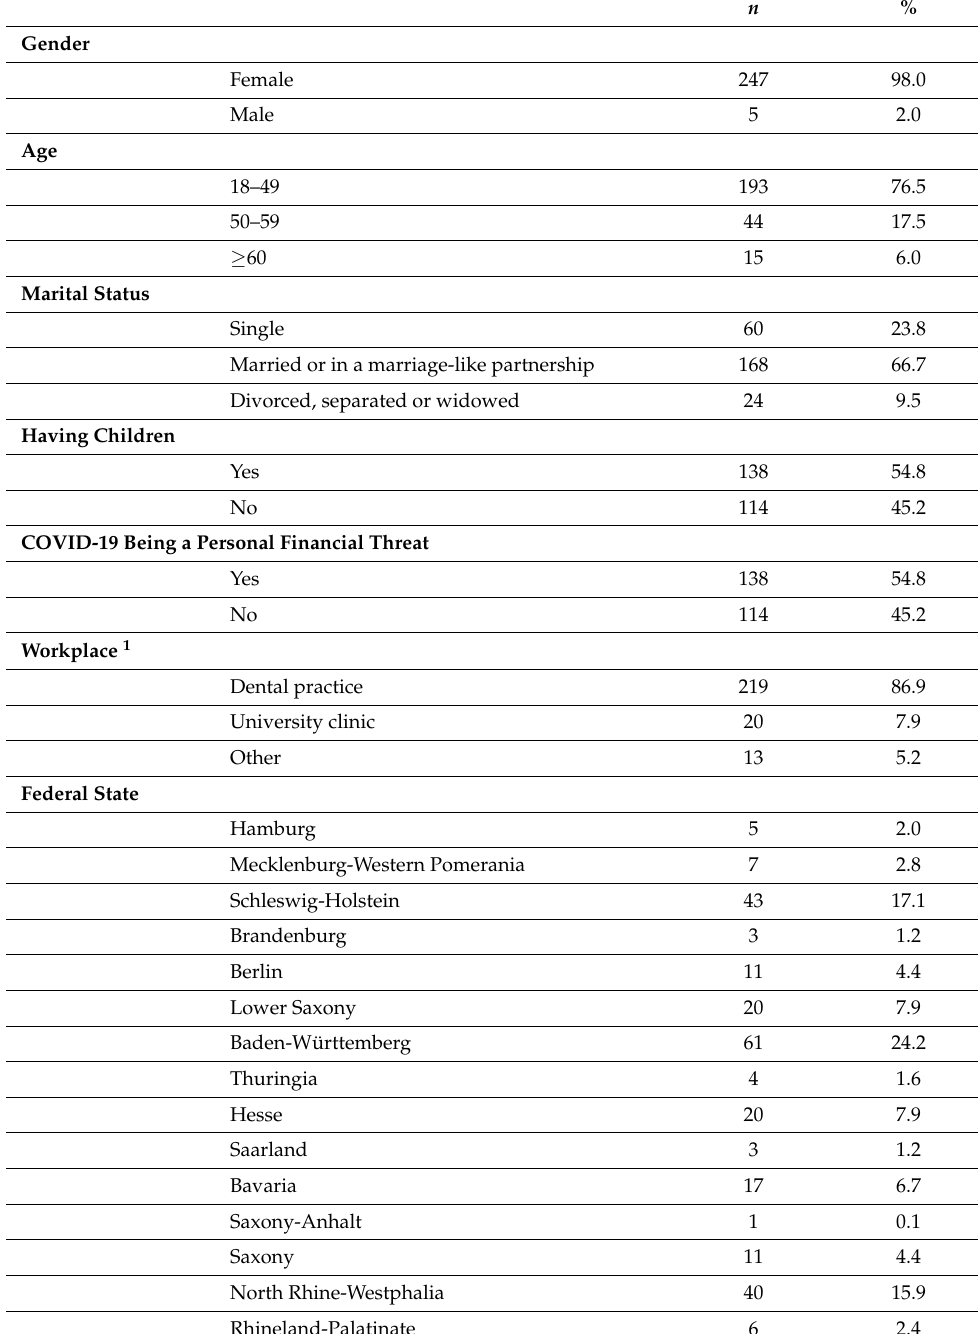
Table 1. Participants’ characteristics ( n =